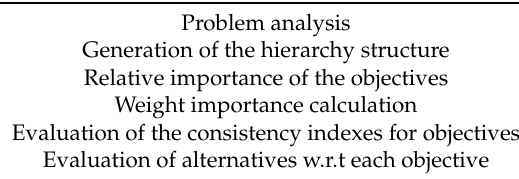
Table 1. Analytic Hierarchy Process (AHP) decision making process.